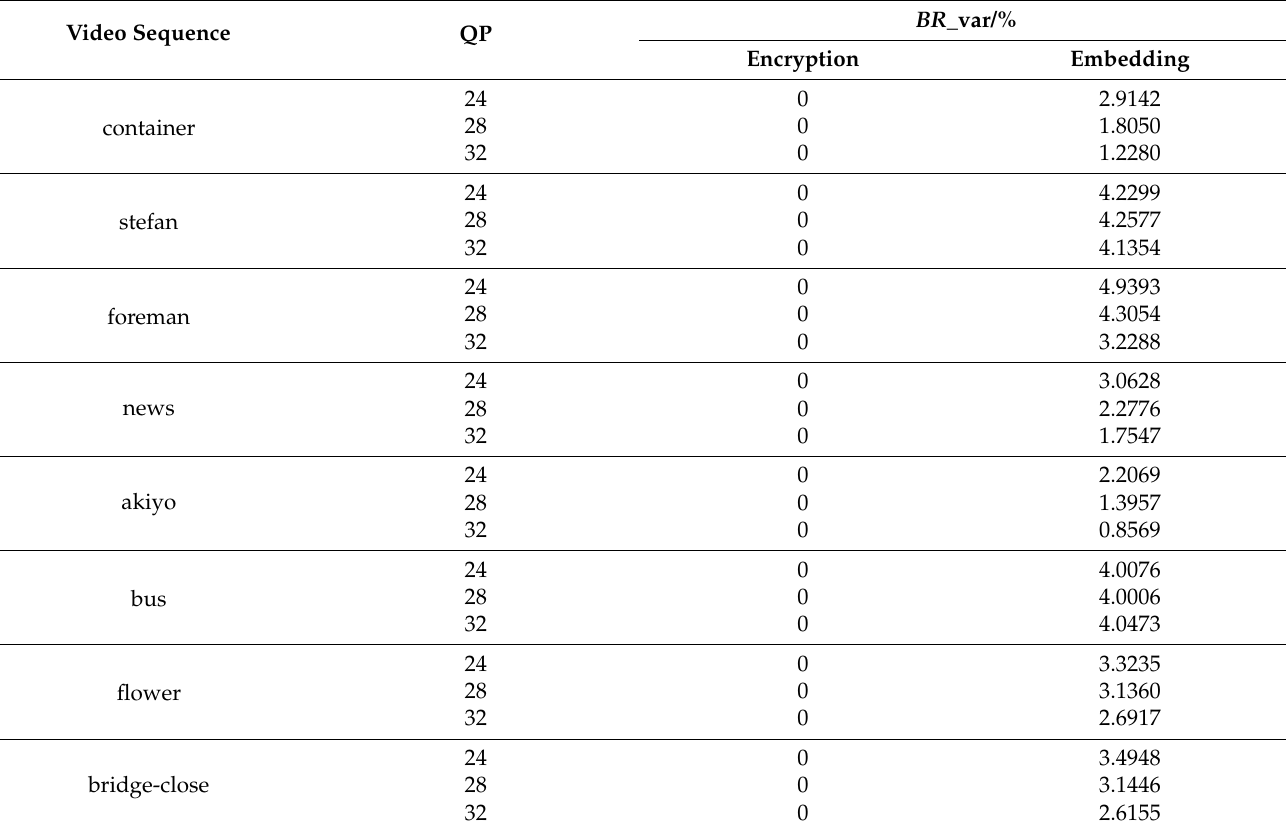
Table 6. Bit rate variation caused by encryption and